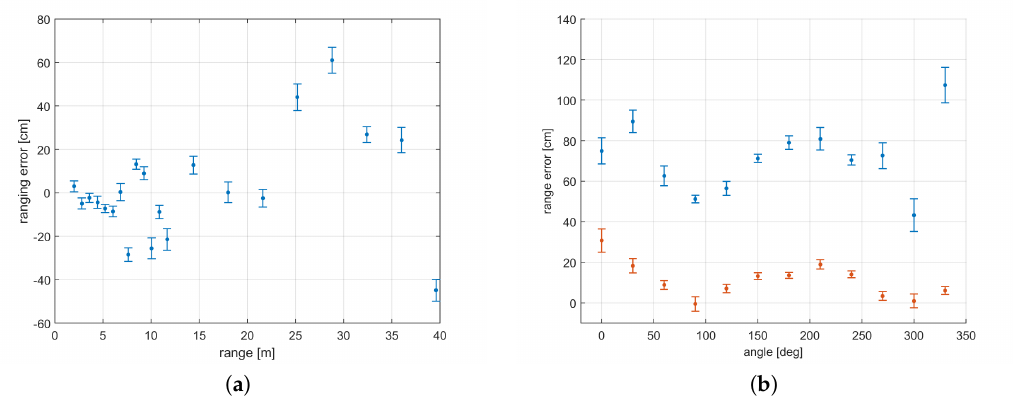
Figure 3. Ranging error characteristics (bars correspond to ± one standard deviation value centered on the bias): errors are obtained varying ( a ) only for distance; and ( b ) only relative orientation between the devices,